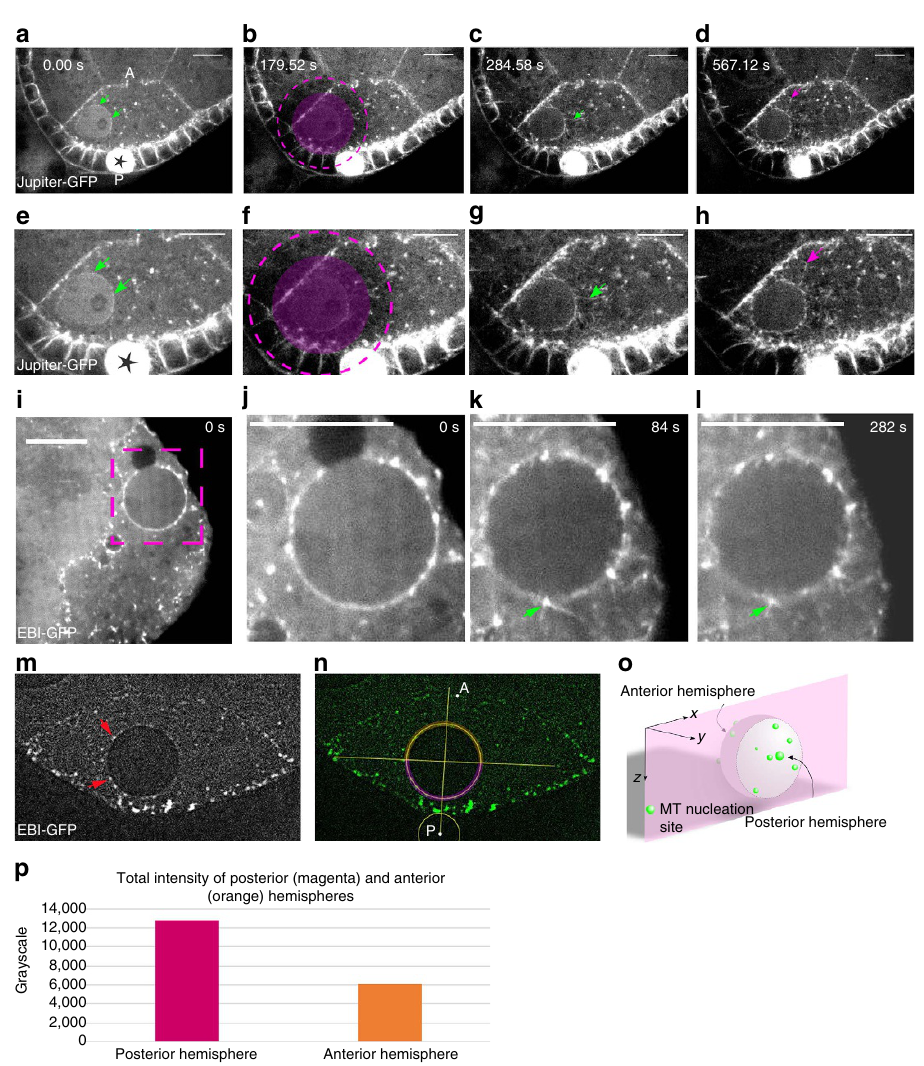
Figure 5 | MTs are nucleated asymmetrically around the nuclear envelope. ( a – h ) Selected frames extracted from a time-lapse movie illustrating Jupiter-GFP labelled MT nucleation after depolymerization by colcemid ( a , e ), and different time after local UV-mediated colcemid inactivation ( b – d , f – h ). The selected ROI for ultraviolet-pulse is marked by a solid magenta disc, and the effective zone of UV-inactivation of colcemid due to short wavelength diffusion materialized by dashed line circles. Green arrows indicate MTnucleation in the vicinity of the nuclear envelope. Pink arrows indicate MTnucleation in the cytoplasm. ( e – h ) Close-ups of the oocyte shown in a – d . A: Anterior, P: Posterior; scale bar, 10 m m. ( i – l ) Selected frames extracted from a time-lapse movie, showing MTnucleation highlighted by EB1-GFP, before ( i , j ) and after UV-mediated colcemid inactivation ( k , l ). ( j – l ) are close-ups of the region boxed in i . The green arrow indicates MT nucleation at the nuclear envelope. Scale bar, 10 m m. ( m – p ) Quantification of the MT nucleation sites highlighted by EB1-GFP around the nuclear envelope. ( m ) MTnucleation sites highlighted by EB1-GFP are visualized as asters (red arrows) in the presence of colcemid that prevents further MTpolymerization. ( n ) For each confocal section, the nuclear envelope is subdivided into anterior and posterior hemispheres, highlighted in orange and magenta respectively. ( o , p ) Quantitative measurement of MT nucleation sites. ( o ) 3D Schematic illustration of peri-nuclear asters of MT nucleation represented as green dots. ( p ) Bar plot presenting the total fluorescence intensity of anterior (orange) and posterior (magenta) EB1-GFP-positive peri-nuclear asters. (Intensities were summed up over 23